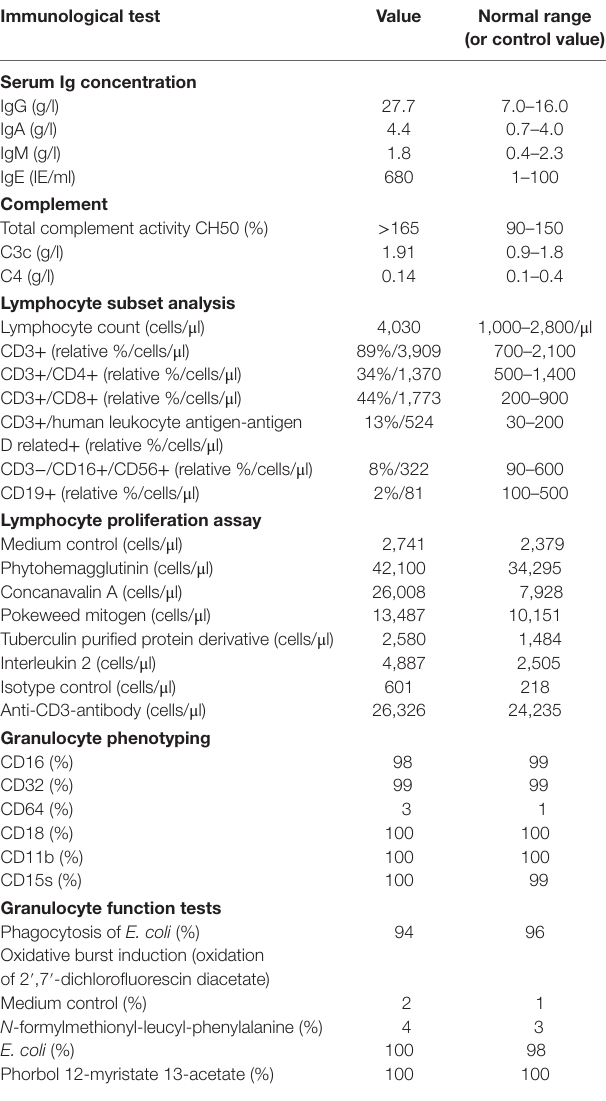
taBle 1 | Immunological findings on admission, directly after diagnosis of disseminated infection with Bacillus Calmette–Guérin in a 47-year-old male with interleukin 12 receptor beta 1